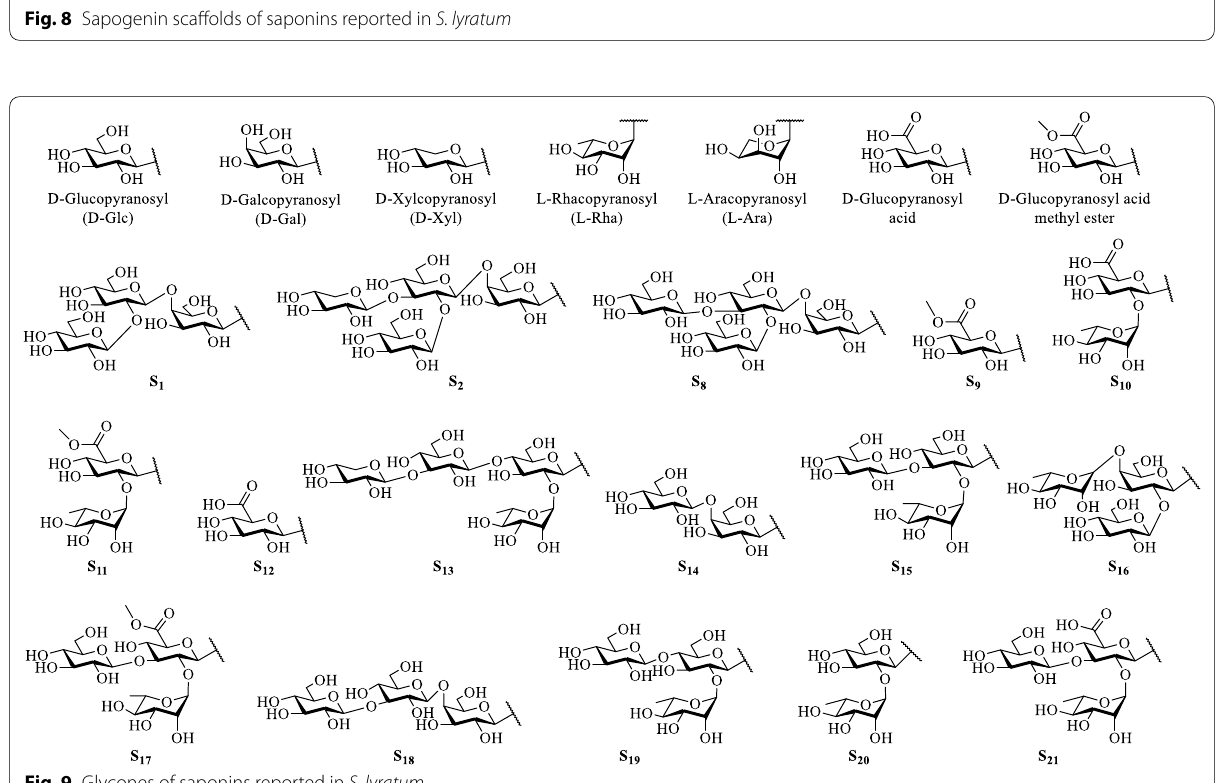
Fig. 9 Glycones of saponins reported in S.